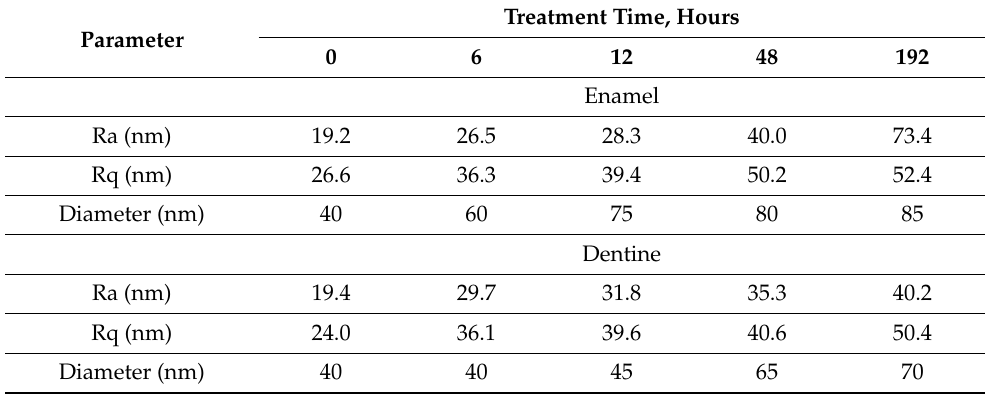
Table 1. Parameters measured with AFM on enamel and dentine